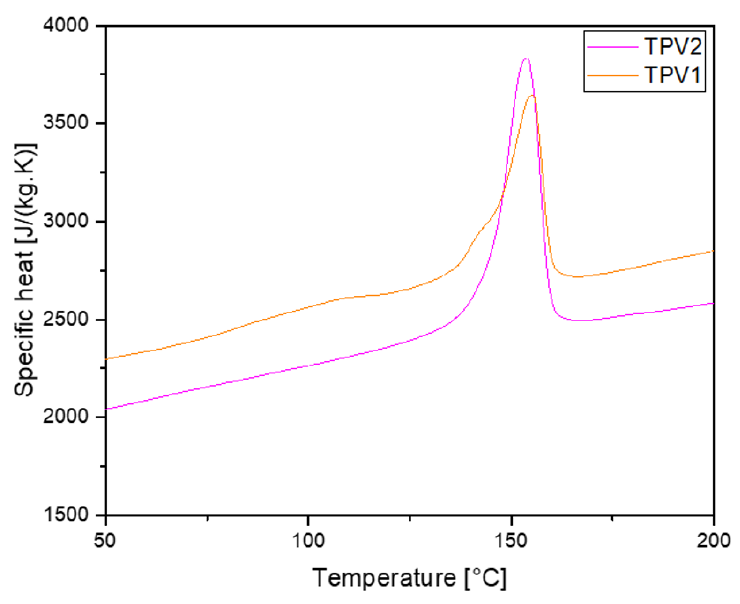
Figure 22. Apparent specific heat versus temperature for our two grades of TPV.